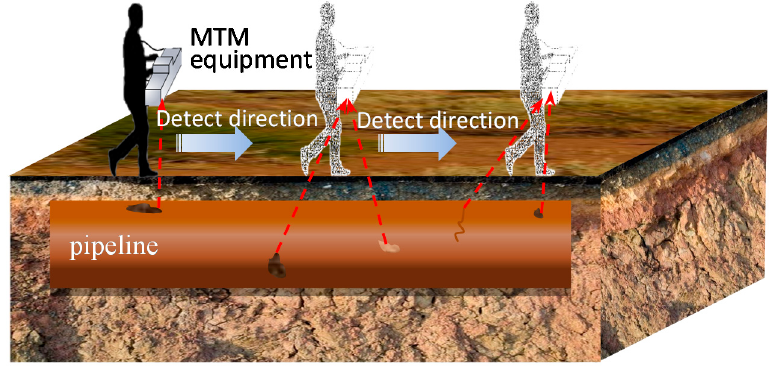
Figure 1. Schematic diagram of magnetic tomography method detection.